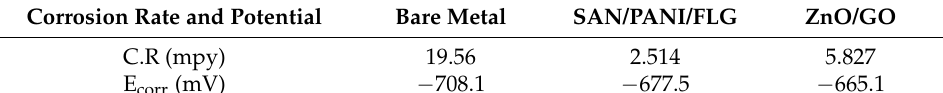
Table 6. Corrosion rate (C.R) data from Tafel scan.